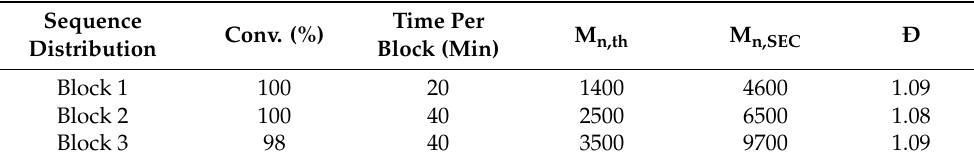
Table 1. Summary of characteristics of triblock copolymers of HEAA, NIPAM and DMA by iterative Cu(0)-mediated polymerization.